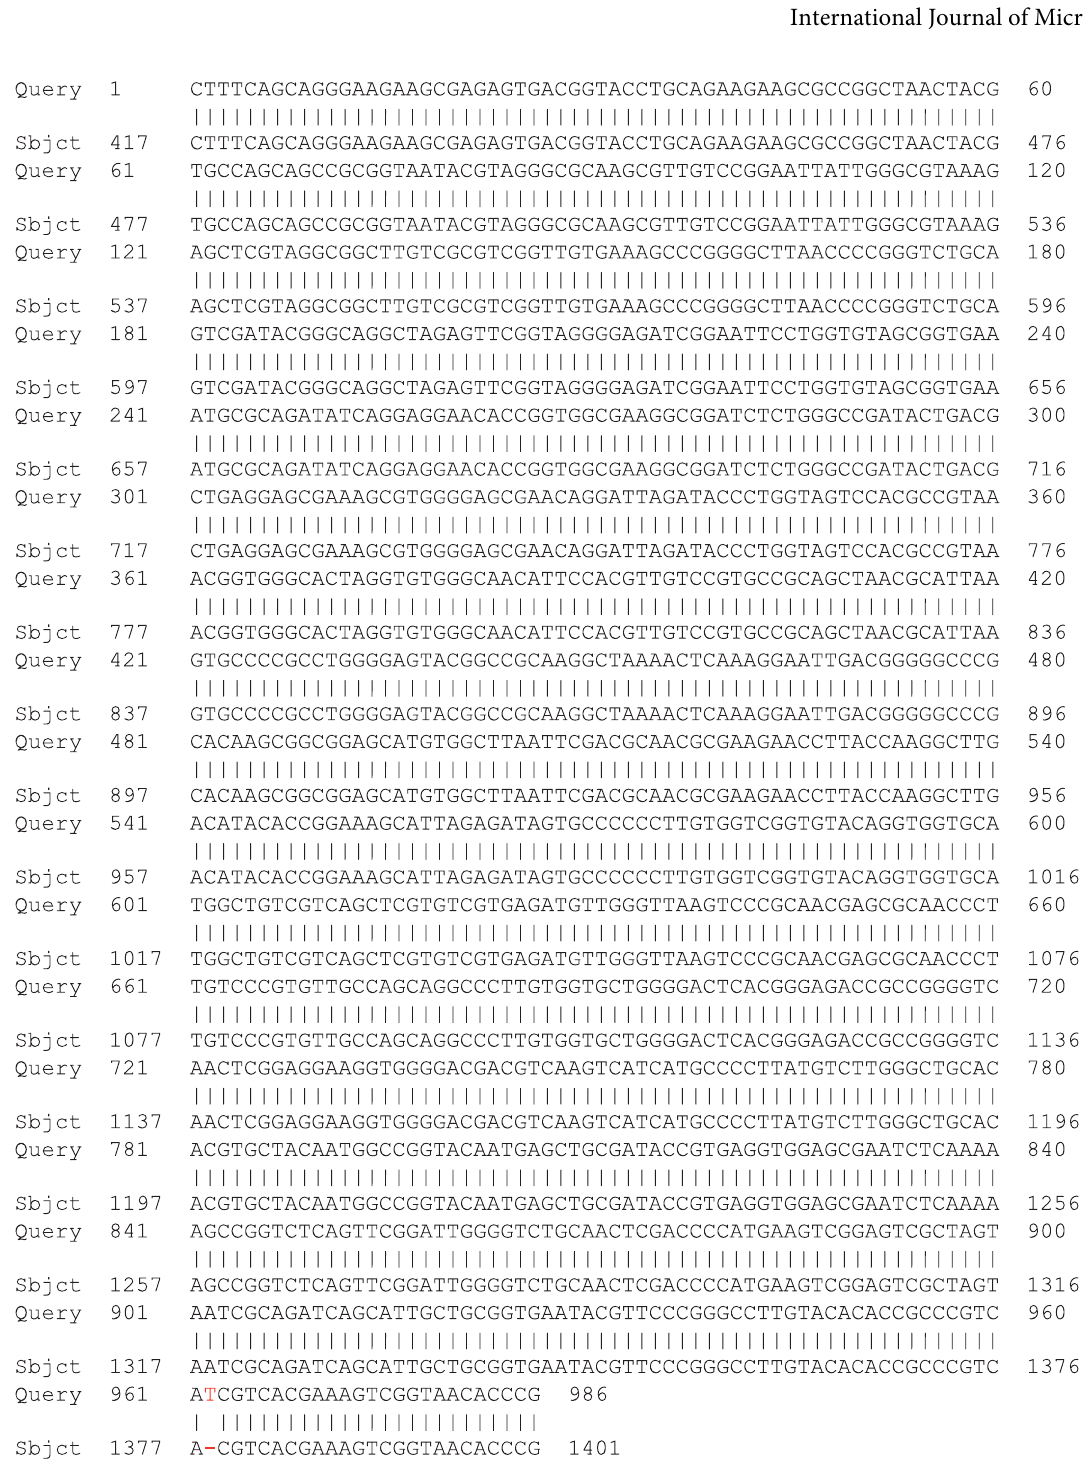
Figure 10: The BLASTanalysis between the KDT32 (query) sequence and Streptomyces sp. MBE174 (AB873097.1) (sbjct � subject) sequence from the NCBI database. The nucleotide with red color indicates the difference between the query (KDT32) and the subject ( Streptomyces sp. MBE174 (AB873097.1))